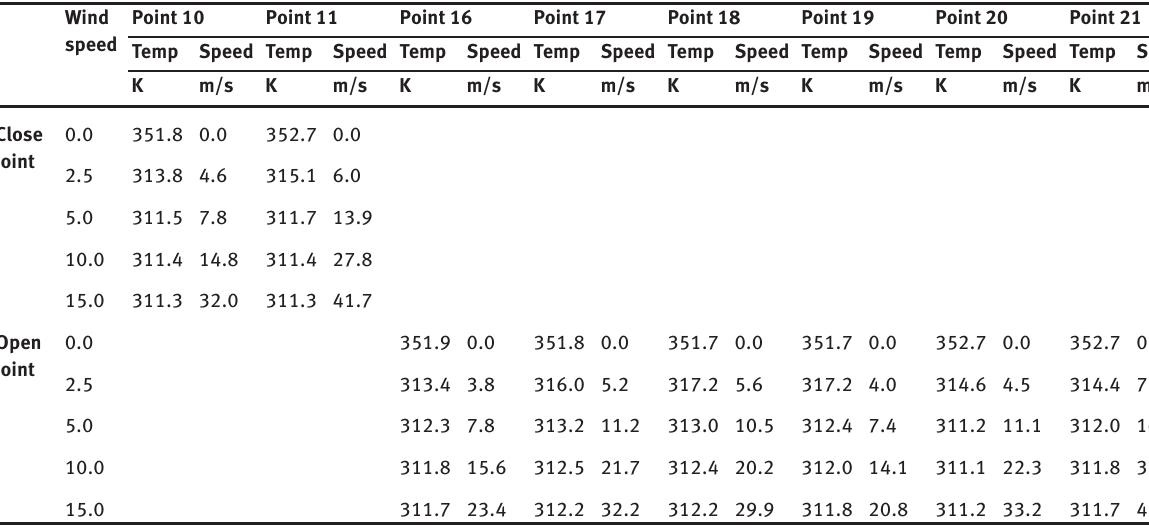
Table 1. Summary of temperatures and air velocities for measurement